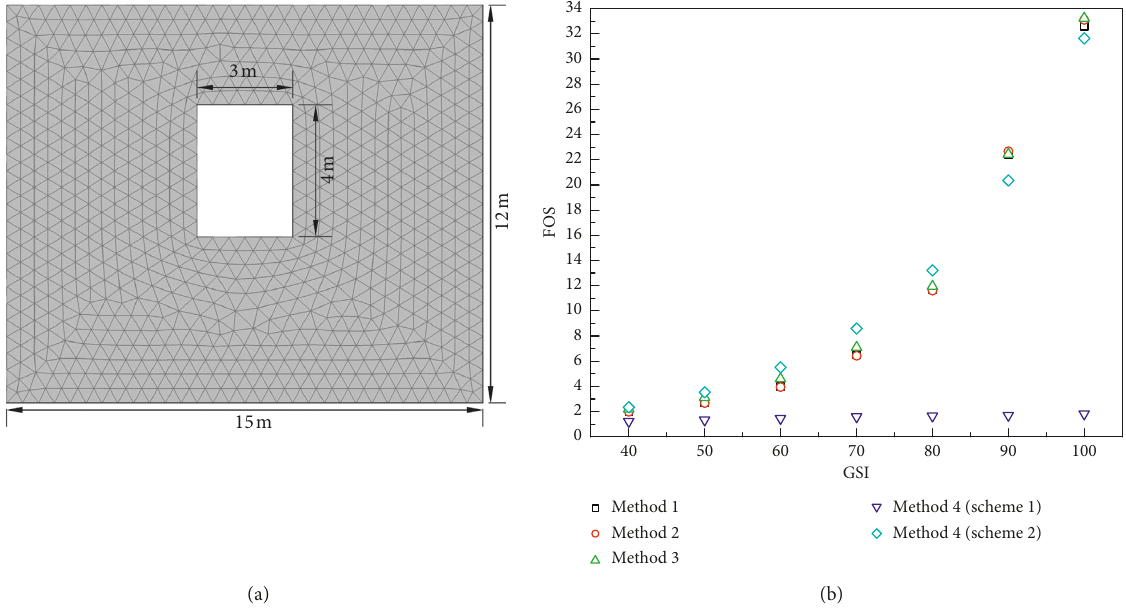
Figure 5: The safety factors of the rectangular cave. (a) The illustration of the rectangular cave and (b) the relationship between FOS and